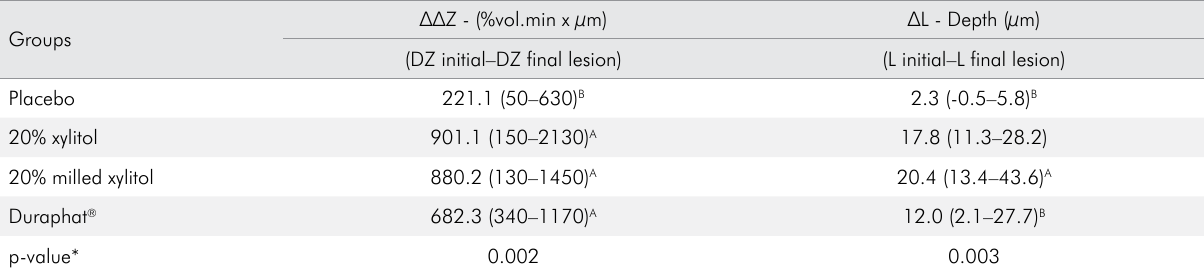
Table 4. Median lesion integrated mineral loss (DDZ) (DZ lesion - DZ final effect) and depth (µm) (DL = L lesion - L final effect) of the pre-demineralized enamel specimens treated with different varnishes in situ (n = 11).